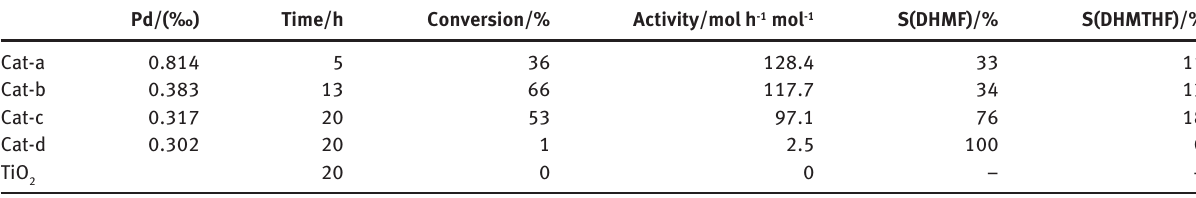
Table 3 The catalytic results of the Pd@TiO Pd/(‰)